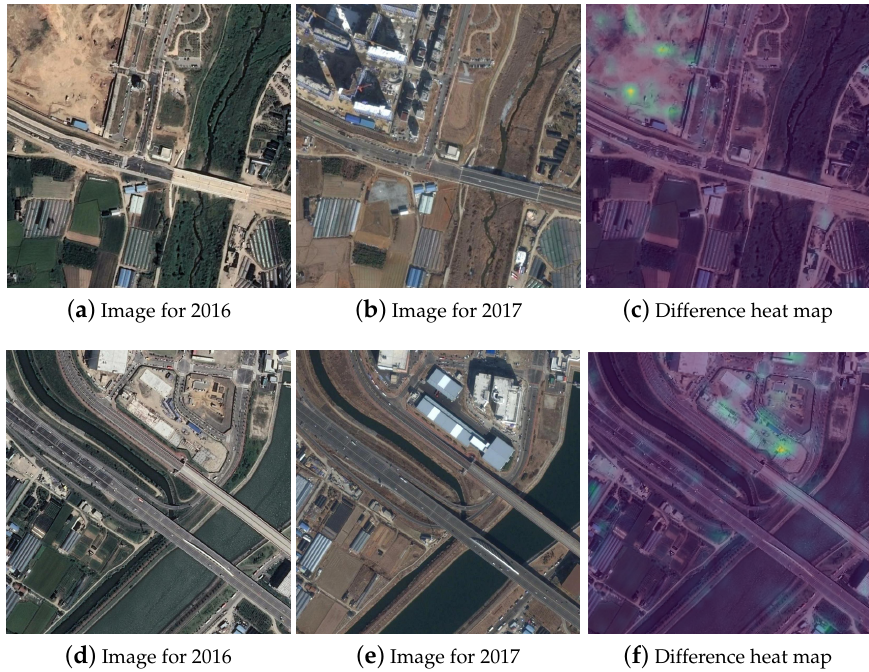
Figure 13. Heat maps representing the differences in features between